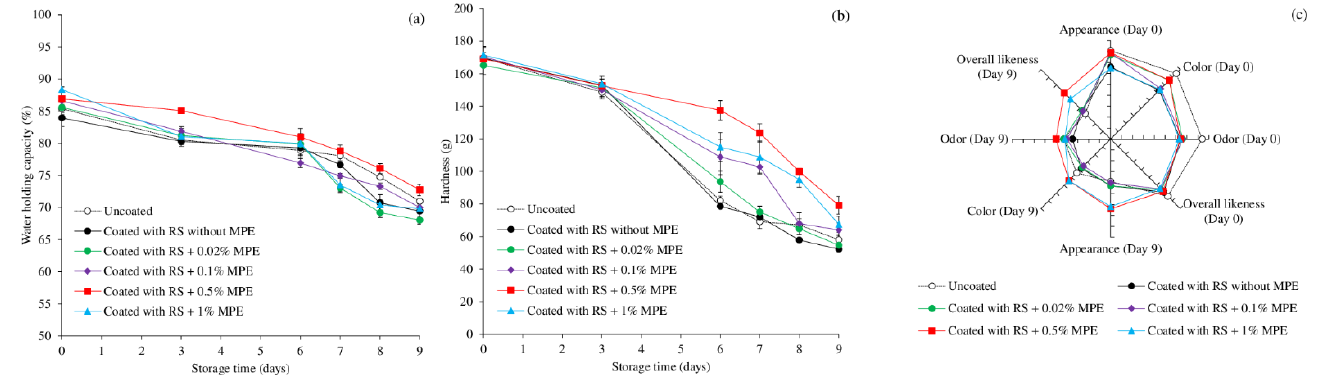
Figure 6. Changes in water holding capacity ( a ), hardness ( b ), and likeness scores ( c ) of mackerel slices over the course of storage at 4 °C influenced by coating with rice starch (RS) containing Mon-pu extract (MPE) at different concentrations. Bars represent standard deviation from triplicate determinations. Using a 9-point hedonic scale, 10 trained panelists evaluated the sensory quality on Days 0 and 9 of storage.